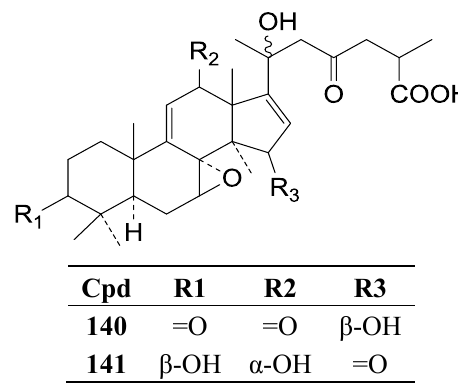
Figure 15. Structures of compounds 140 ‒ 141 .